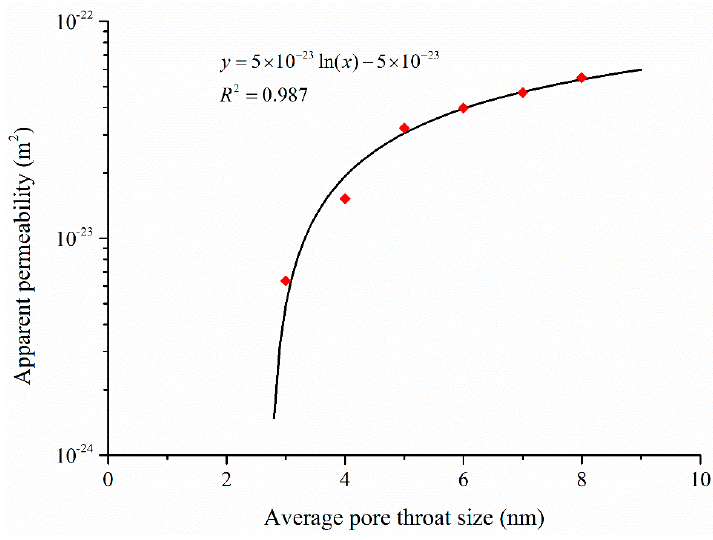
Figure 7. Variation of the apparent gas permeability with pore throat sizes.